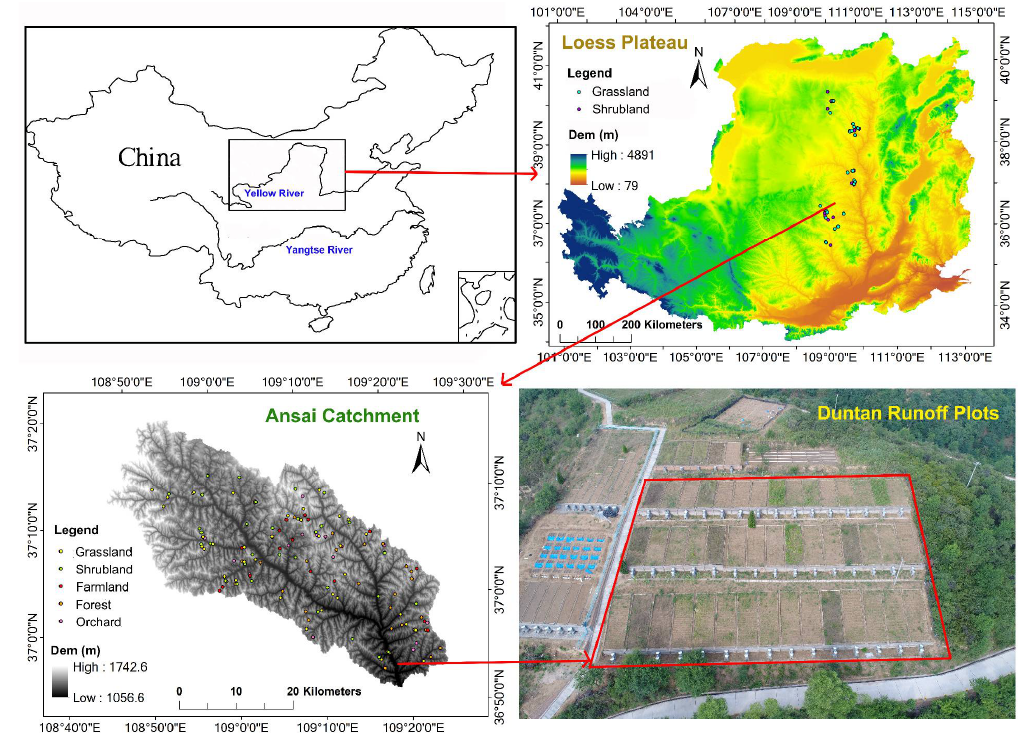
Figure 1. The distribution of sampling points.